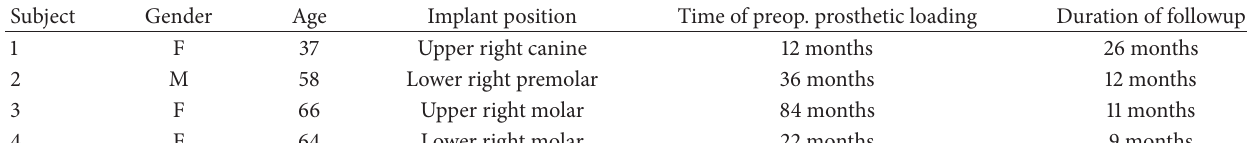
Table 1: Demographic data describing the four study subjects.